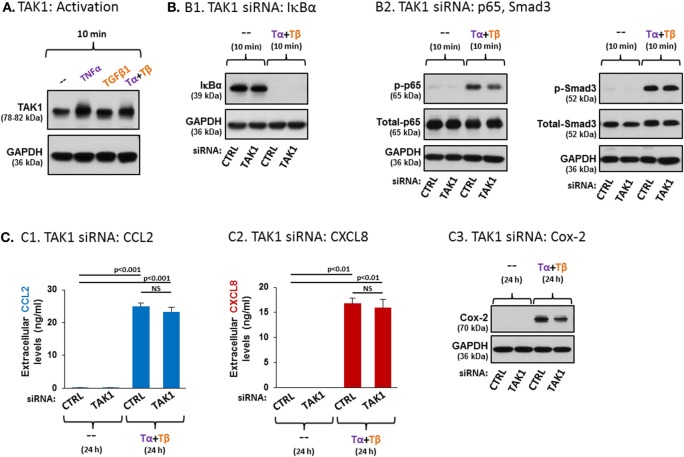
TAK1 plays divergent roles in regulating TNFα + TGFβ1 cooperatively-induced CCL2/CXCL8 and Cox-2 expression in MSCs. (A) Human BM-derived MSCs were stimulated with vehicle (“--”), TNFα (50 ng/ml), TGFβ1 (10 ng/ml), or TNFα + TGFβ1 (same concentrations) for 10 min (FBS-free medium). Tα + Tβ = TNFα + TGFβ1. TAK1 expression was determined by WB; GAPDH was used as a loading control. The findings are representatives of n = 3 independent experiments, performed with MSCs of three different donors, which have shown similar results. (B,C) The effects of TAK1 downregulation on MSC signaling and functions. siRNA concentrations were determined by preliminary titration analysis (data not shown). (B) Signaling: human BM-derived MSCs were transiently transfected with control siRNA (“CTRL”, 50 nM) or with siRNA to TAK1 (50 nM; efficacy of TAK1 downregulation is demonstrated in Figure S6A1 in Supplementary Material). Following siRNA transfection, the cells were stimulated with vehicle (“--”) or with TNFα (50 ng/ml) + TGFβ1 (10 ng/ml) for 10 min (0.5% FBS-containing medium). Tα + Tβ = TNFα + TGFβ1. (B1) The expression levels of IκBα were determined by WB; GADPH was used as loading control. (B2) p65 and Smad3 activation levels were determined as described in Figure 5. p38 activation levels are demonstrated in Figure S6A2 in Supplementary Material. (C) Function: human BM-derived MSCs were transiently transfected with control siRNA (“CTRL”, 50 nM) or with siRNA to TAK1 (50 nM; efficacies of TAK1 downregulation are demonstrated in Figures S6B1,B2 in Supplementary Material). Following siRNA transfection, the cells were stimulated with vehicle (“--”) or with TNFα (50 ng/ml) + TGFβ1 (10 ng/ml) for 24 h (0.5% FBS-containing medium). Tα + Tβ = TNFα + TGFβ1. The impact of TAK1 siRNA on the expression of CCL2 (C1), CXCL8 (C2) and Cox-2 (C3) was determined as described in Figure 5. NS, not significant. In all panels, the findings are representatives of n = 3 independent experiments, performed with MSCs of two different donors, which have shown similar results. Similar findings, obtained in MSCs from another donor, are demonstrated in Figure S7 in Supplementary Material (each panel with its corresponding validation of downregulation efficacy).